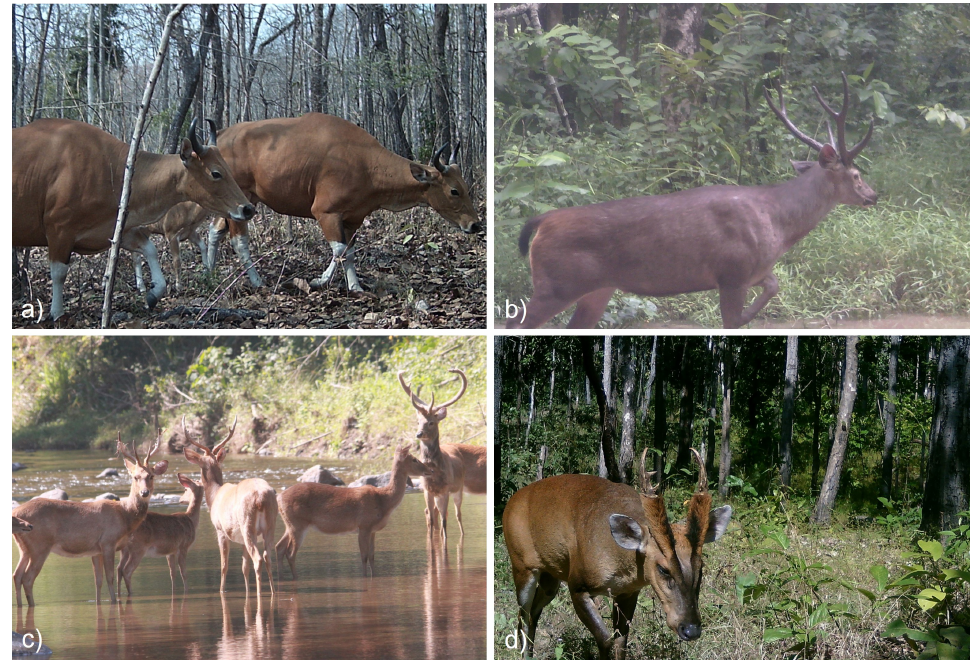
Figure 1. Large herbivores found in the study area: ( a ) banteng ( Bos javanicus ); ( b ) sambar deer ( Rusa unicolor ); ( c ) eld’s deer ( Rucervus eldii ) and ( d ) red muntjac ( Muntiacus muntjak